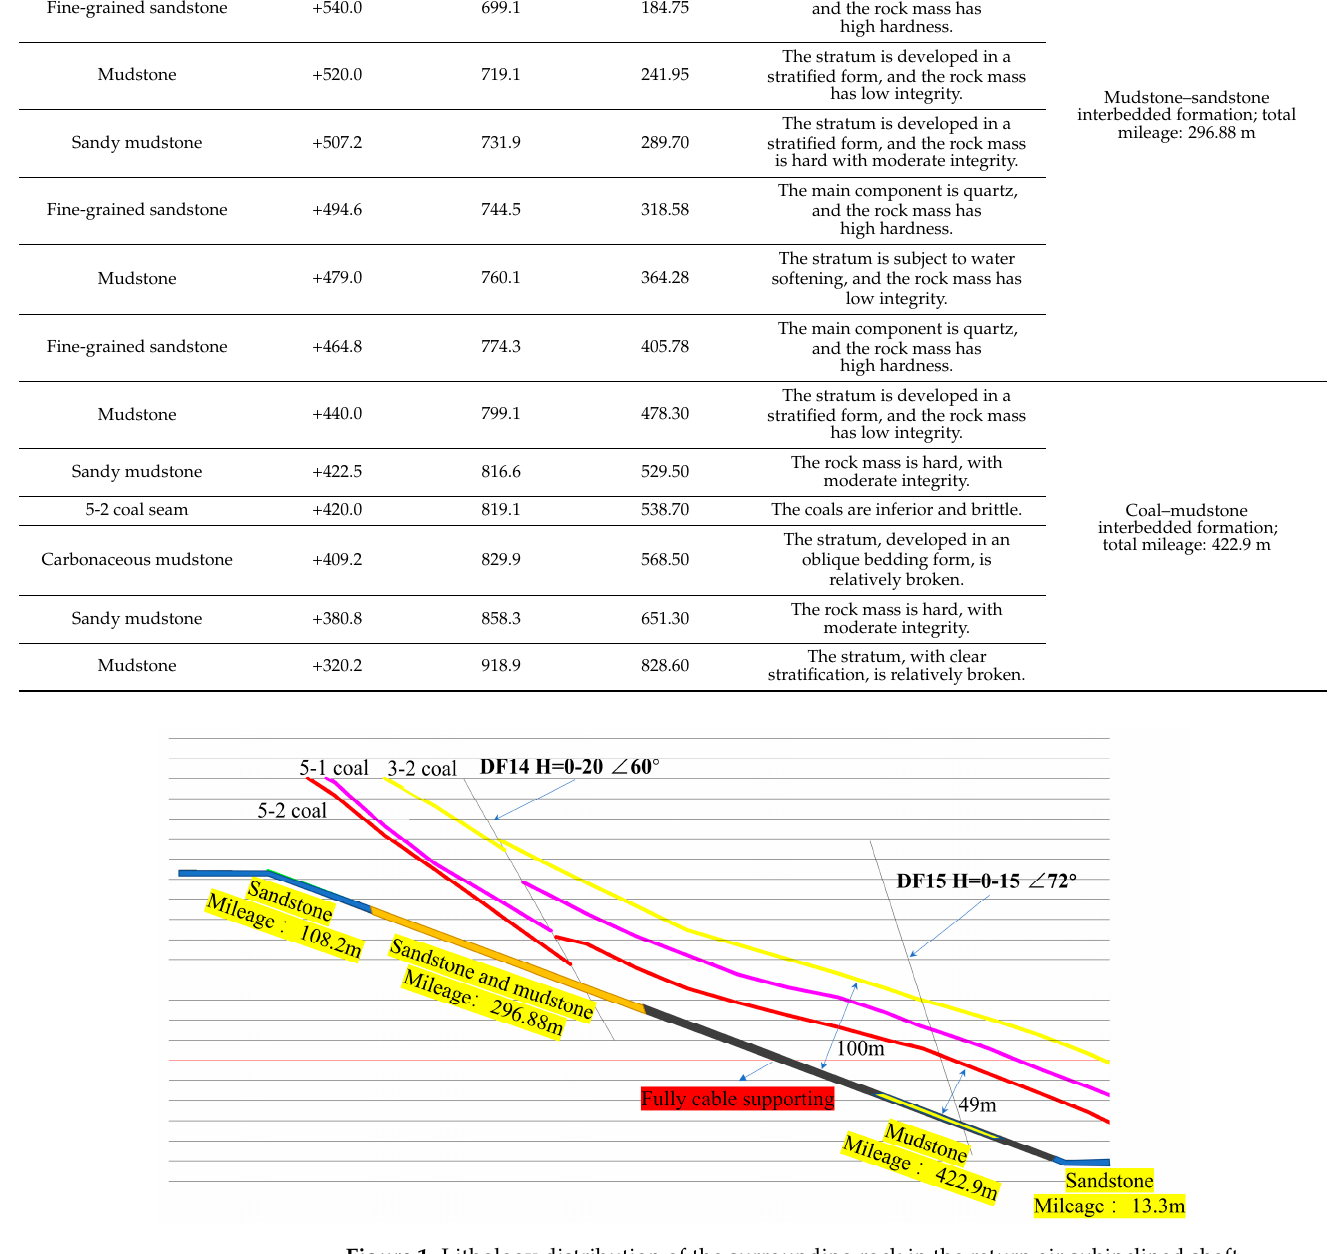
obvious in fl uence of geologic structures, it also passes through three tectonic fault zones. The in situ stress test indicates that horizontal stress greatly a ff ects this roadway, showing a side-pressure coe ffi cient of 1.4–1.5. In addition, there is an angle of about 25–43° between the maximum horizontal stress and the axis of this roadway. 2.2. Original Support Scheme The return air subinclined shaft, which is 5.5 m wide and 4.95 m high, has a semicir- cular arch section of 23.98 m 2 with vertical walls at a height of 2.2 m. The entire roadway is supported according to the same scheme, as shown in Figure 2. Figure 2. Cross-sectional diagram for the bolt-cable coordinated support in the return air subin- clined shaft.